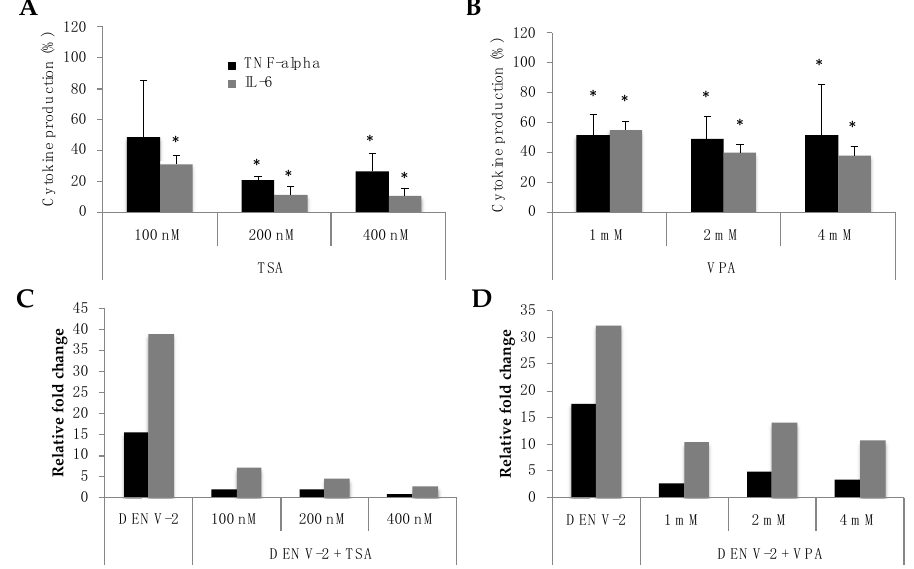
Figure 1. Trichostatin A (TSA) and valproic acid (VPA) pretreatment of peripheral blood mononuclear cells (PBMCs) infected with dengue virus (DENV ‐ 2) exhibit a decrease TNF ‐ alpha and IL ‐ 6 production. PBMCs were treated with TSA ( A ) or VPA ( B ) for 3 h and then were infected with DENV ‐ 2. At 24 h post ‐ infection, the supernatants were used to quantify cytokine production. Data is expressed as relative cytokine production compared with infected non ‐ treated control cells. Error bars represent the mean ± SEM of three independent experiments. * p values were calculated using the non ‐ parametric two ‐ tailed Mann ‐ Whitney test, comparing each experimental condition with the infected non ‐ treated control. A p value < 0.05 was considered significant. PBMCs were treated with TSA ( C ) or VPA ( D ) for three hours and were then infected with DENV ‐ 2. At 3 h post ‐ infection, total RNA was collected to quantify cytokine mRNA. Gene expression was normalized to human β‐ actin expression. The figure shown is representative data from one of three independent experiments.